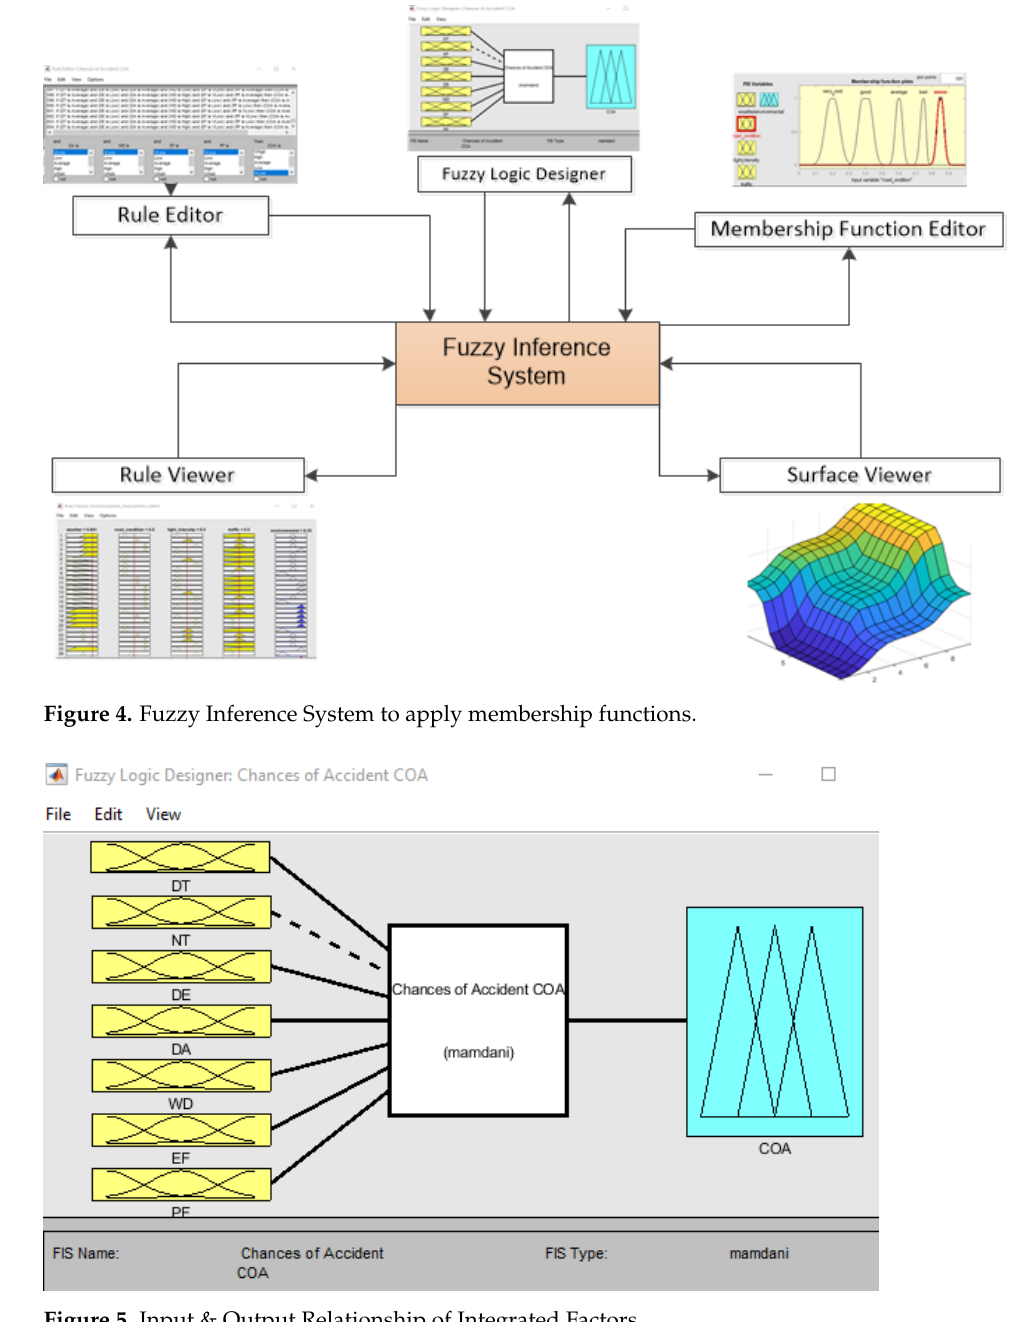
Figure 5. Input & Output Relationship of Integrated